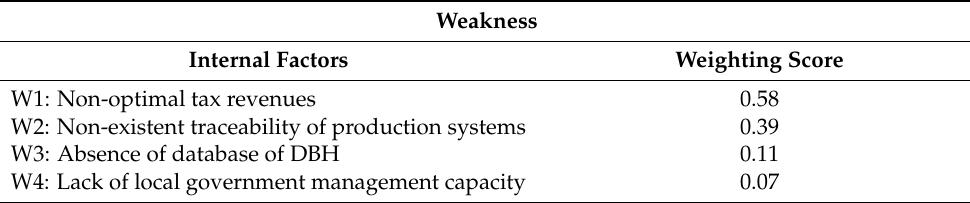
Table 5. Weaknesses hindering the adoption of DBH